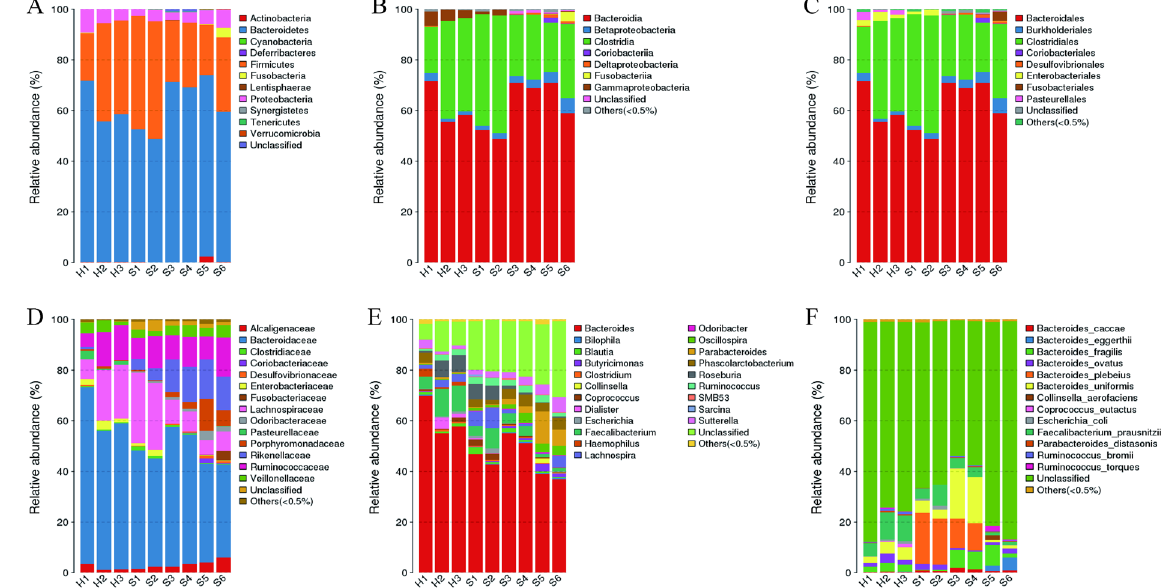
Figure 1. Microbiota composition of healthy donors and STC donors. ( A ) Phylum level; ( B ) Class level; ( C ) Order level; ( D ) Family level; ( E ) Genus level; ( F ) Species level. STC: slow transit constipation; Group H (n = 3): healthy donor; Group S (n = 6): slow transit constipation donor.